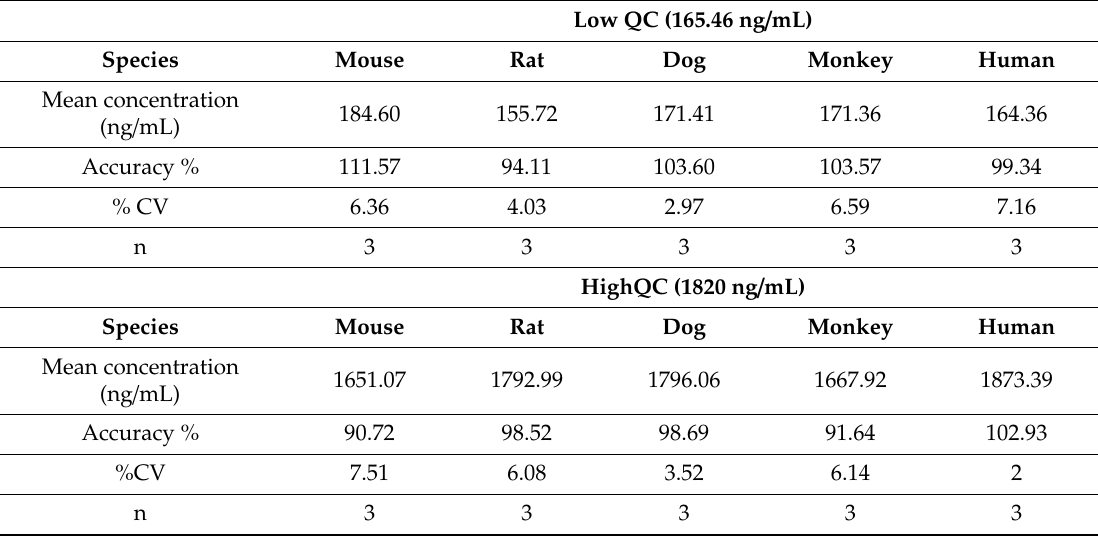
Table 3. The species-dependent matrix e ff ect of MMAF (monomethyl auristatin F). Low QC (165.46 ng /